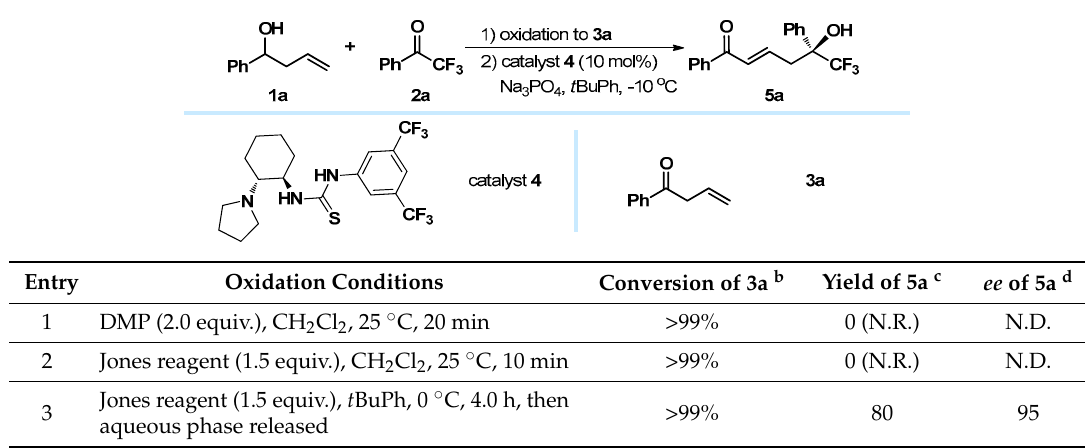
Table 1. Investigation of reaction conditions a .